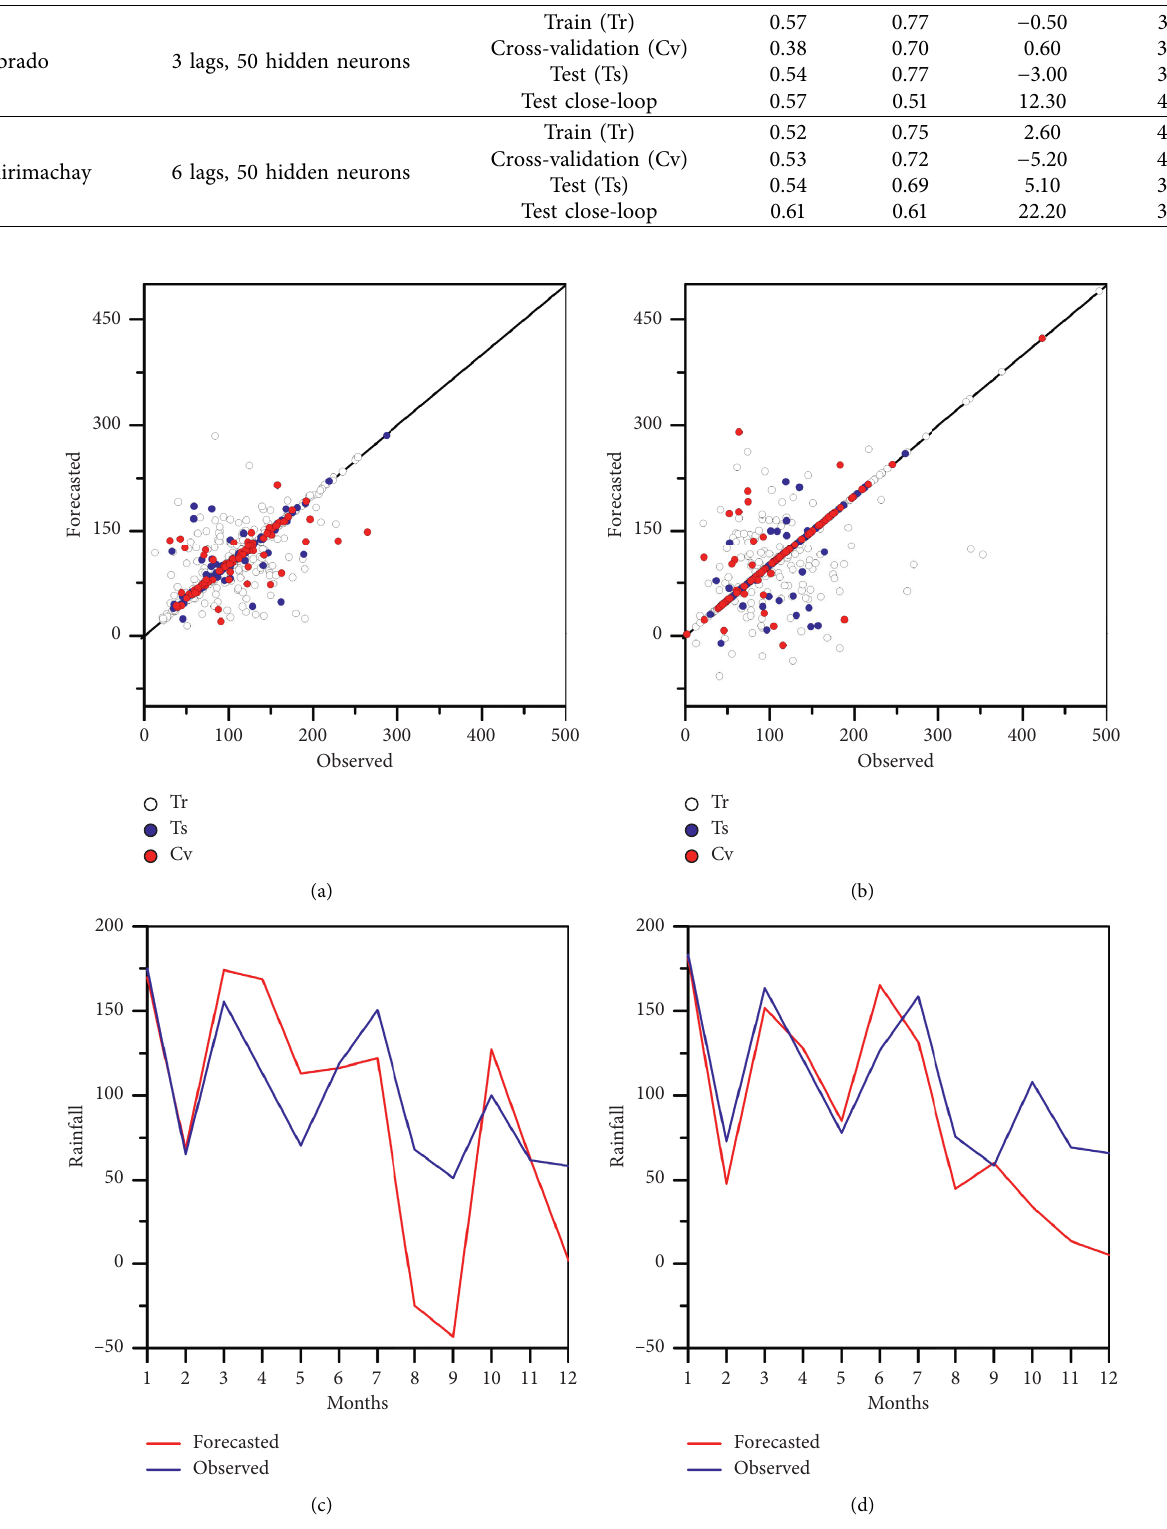
Figure 7: Comparison between predicted and observed values: (a) training subset for Labrado; (b) training subset for Chirimachay; (c) forecasting for Labrado in 2015; (d) forecasting for Chirimachay in